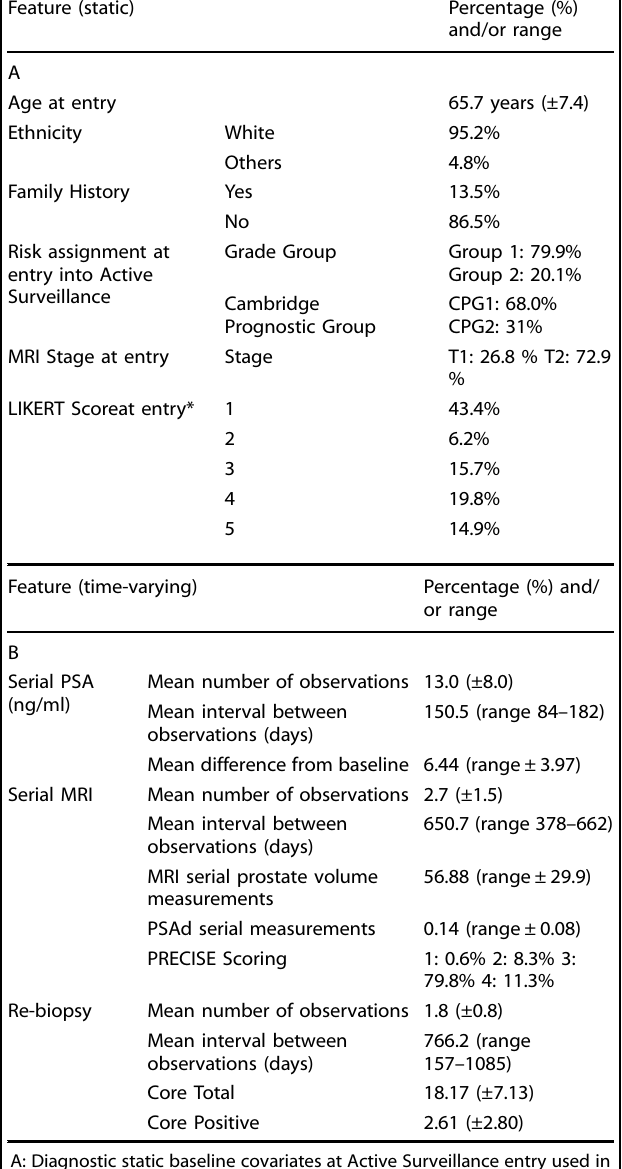
Table 1. Summary of cohort and data variables collected.